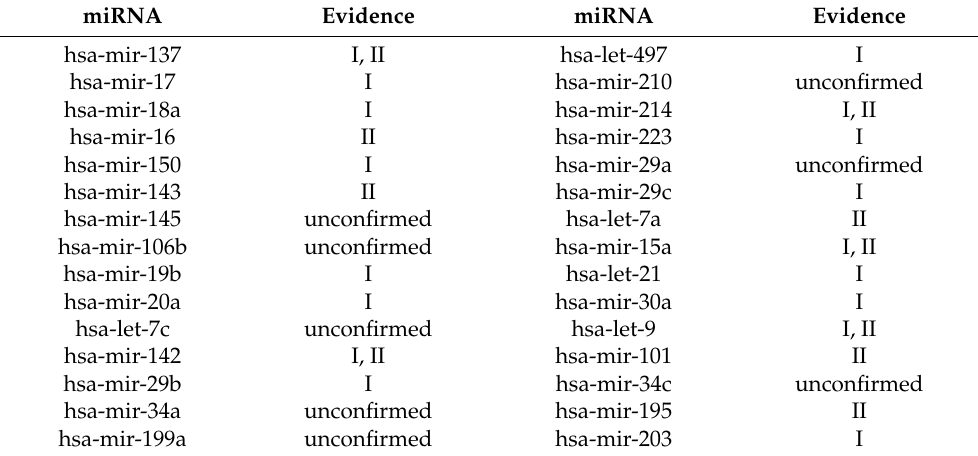
Table 2. The top 30 thyroid cancer-related miRNAs predicted by the RNSSLFN model. (Column 1: top 1–15 miRNA names; Column 3: top 16–30 miRNA names. I and II represent the association between the miRNA and thyroid cancer, which has been verified in the databases dbDEMC and miRCancer, respectively).